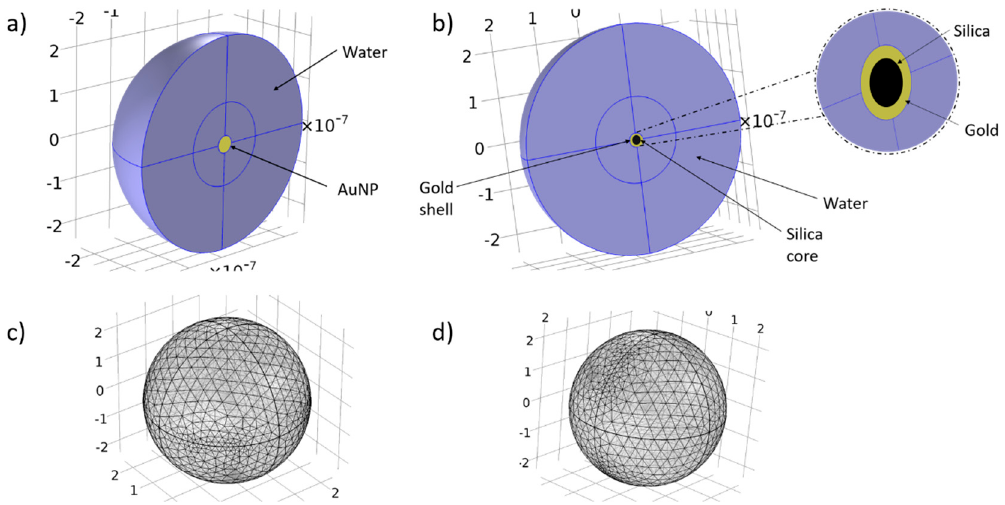
Figure 7. Corresponding geometries and meshes for the simulation of plasmon resonance. ( a , c ), AuNP with a 40 nm diameter surrounded by 225 nm of water; ( b , d ) AuSiO 2 NP with a 30 nm diameter (20 nm SiO 2 , 5 nm Au layer) surrounded by 225 nm of water.